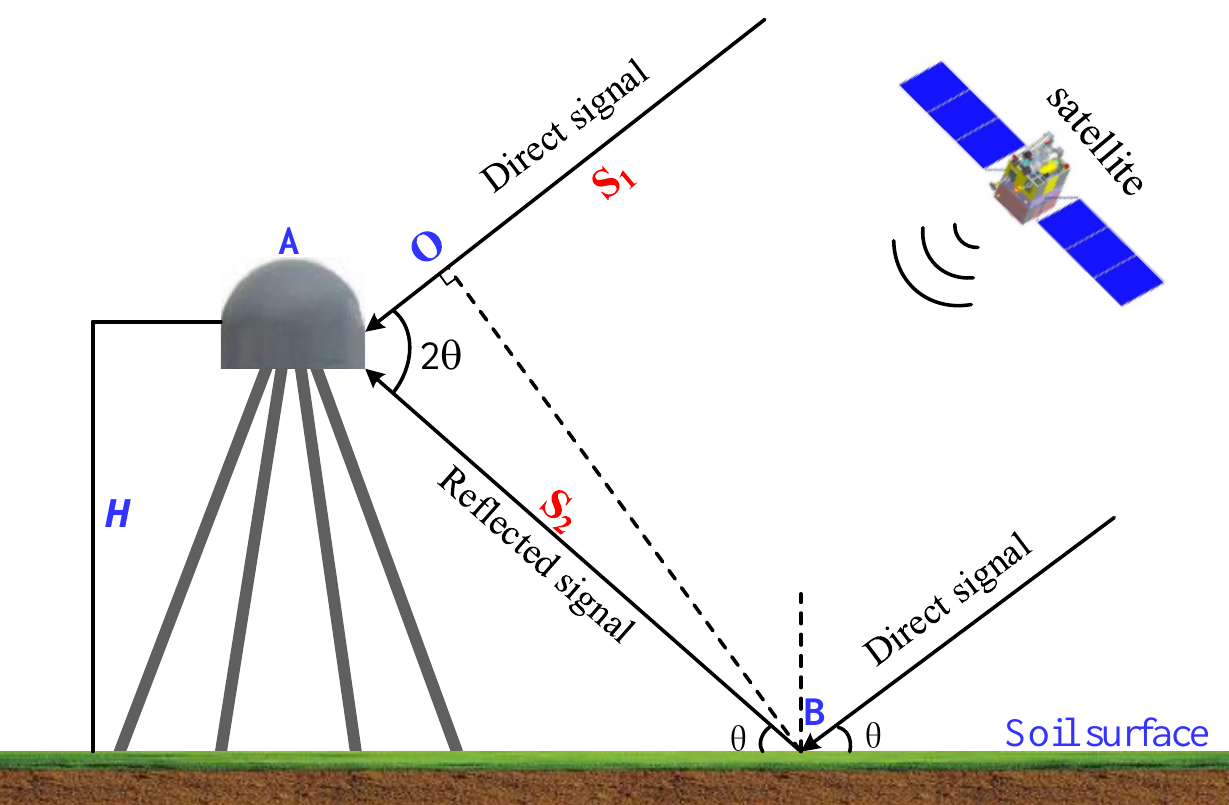
Figure 1. Schematic diagram of GNSS-IR SMC retrieval. After the satellite sends the signal, the right- handed circular polarized (RHCP) antenna receives the direct signal and the surface reflected signal, producing an interference effect at the receiver. A is the GNSS receiver antenna; B is the reflection point position of GNSS satellite signals passing through the ground; O is the footing point of the vertical line between the over-reflection point and the GNSS satellite direct signal; 𝜃 is the eleva- tion angle of the satellite; 𝑆 1 is the direct satellite signal received by the receiver antenna; 𝑆 2 is the reflected signal reflected by the object ’ s surface around the receiver antenna and enters the antenna; 𝐻 is the vertical height from the antenna phase center to the ground.